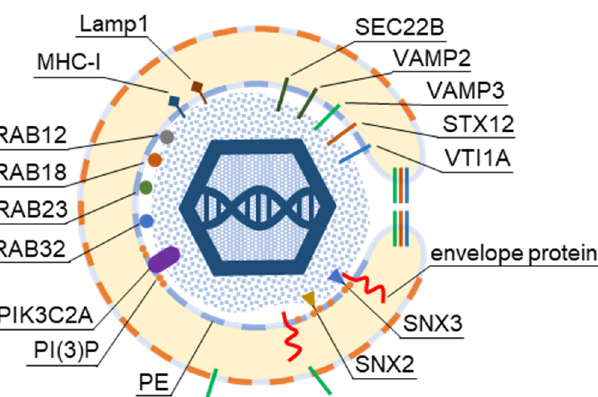
Figure 9. Host cell signatures in HCMV virions that may reveal the envelopment